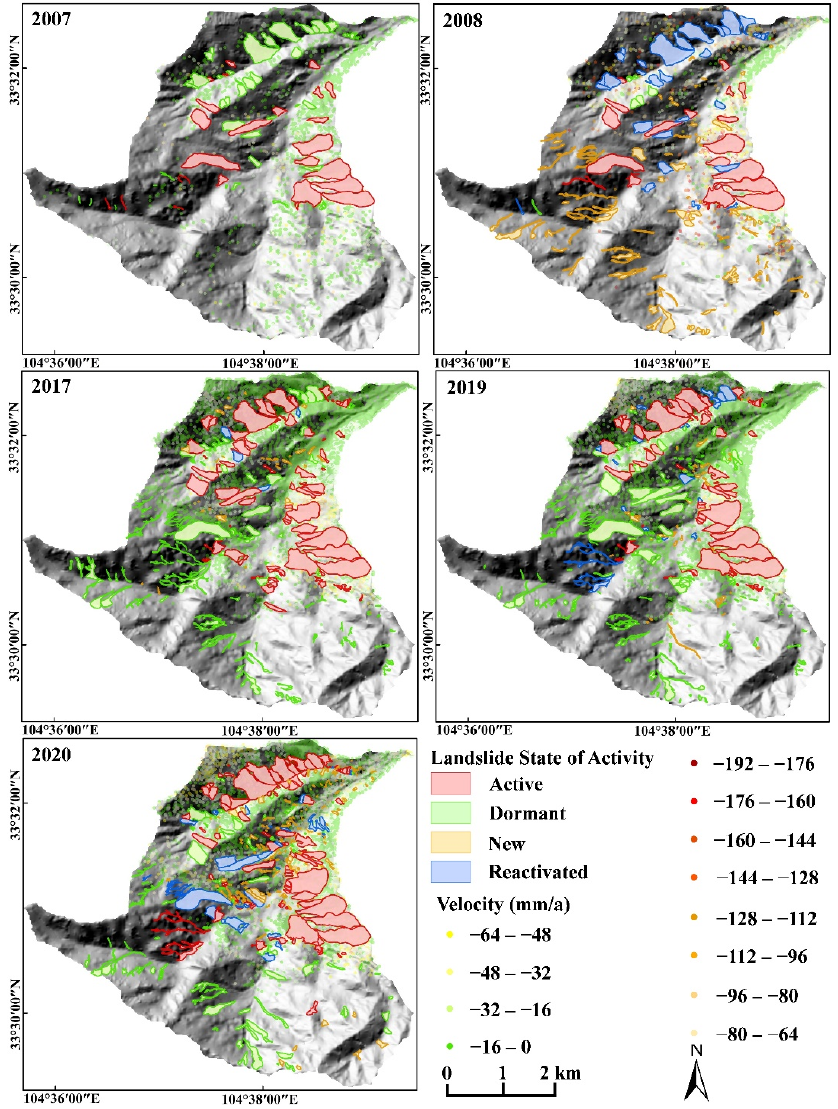
Figure 12. Distribution of landslide activity in different years.